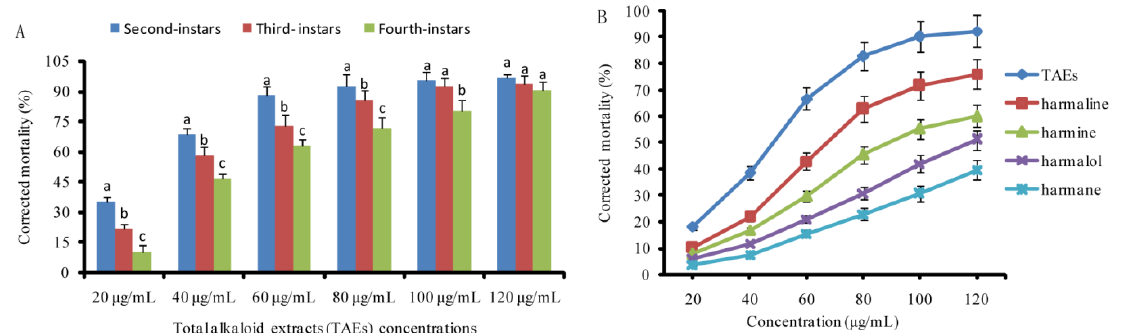
Figure 2. Individual toxicity of the tested alkaloids against Aedesalbopictus larvae. ( A ) Corrected mortality of the total alkaloids of P. harmala seeds (TAEs) against the second-, third- and fourth-instar larvae of A. albopictus at 48 h post-treatment. ( B ) Comparison of individual toxicity of pure alkaloids and TAEs against third-instar larvae of A. albopictus at 48 h post-treatment. Corrected mortality ( ± SE) followed by different letters in the same concentration in bars indicate significant difference ( p < 0.05) according to Tukey’s